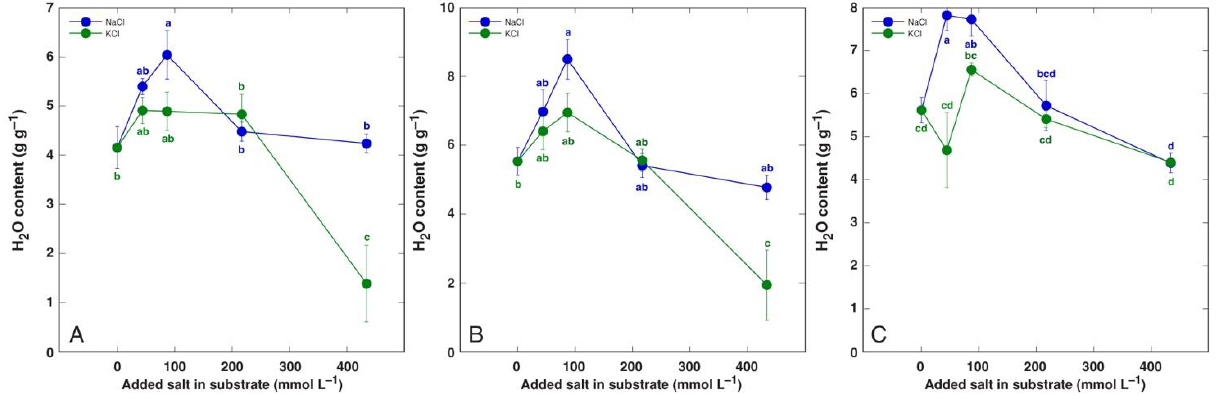
Figure 7. Tissue water content of old leaves ( A ), young leaves ( B ), and roots ( C ) of Plantago maritima plants cultivated in soil and treated with different doses of NaCl and KCl. Different letters indicate statistically significant ( p < 0.05) differences between treatments. Figure is taken from Ievinsh et al., 2022 [184].